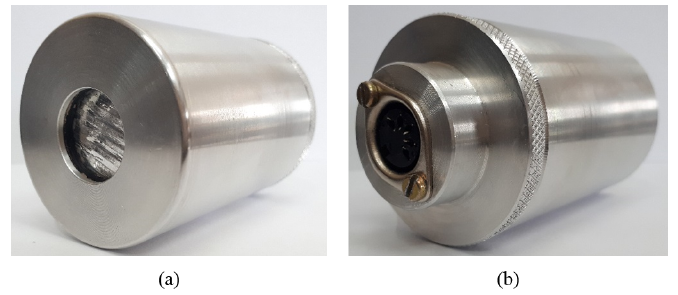
Figure 6. Acoustic transducer, seen in perspective: ( a ) frontal side; ( b ) and rear